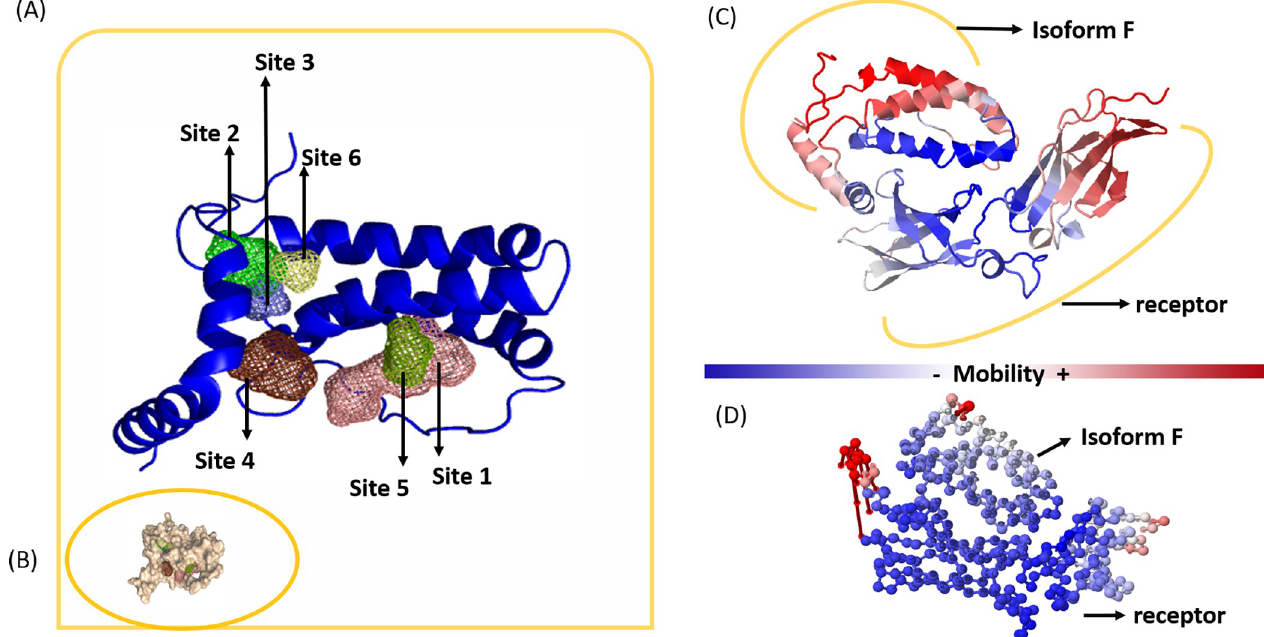
Fig 3. Particularities of the complex formed between the Isoform F and IL-10R1. (A) Binding sites detected in the isoforms. Site 1: Pink; site 2: Green; site 3: Lilac; site 4: Brown; site 5: Olive green. (B) Representation of the isoform F on the surface. (C) Bioactive conformation of the isoform F coupled to the IL-10R1. (D) Vectors obtained by calculating the normal modes, where we observe regions with less movement (more rigid) (blue), regions composed of residues with high movement (pink and red), and regions with intermediate movement (white).